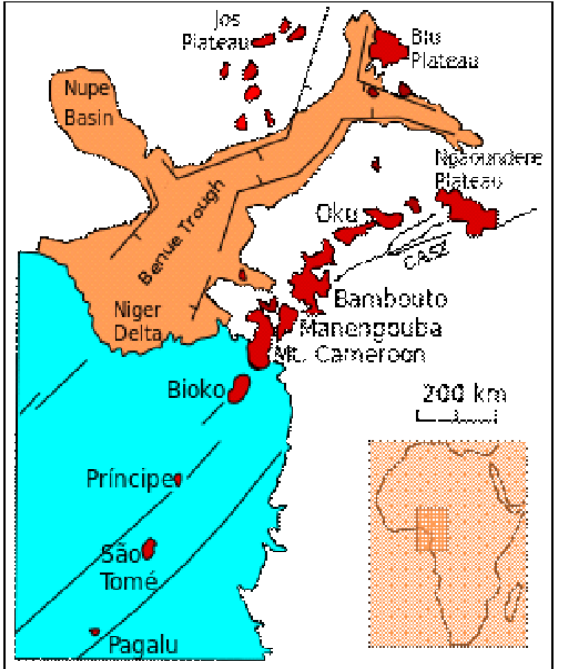
Figure 2: The geological map of Plateau basement rocks.